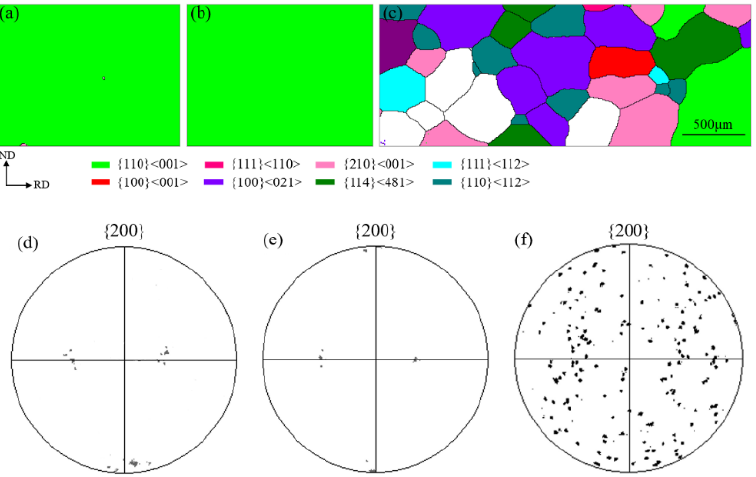
Figure 2. EBSD orientation maps and pole figures of samples extracted at 1200 °C. ( a , d ) S1 steel; ( b , e ) S2 steel; ( c , f ) S3 steel.